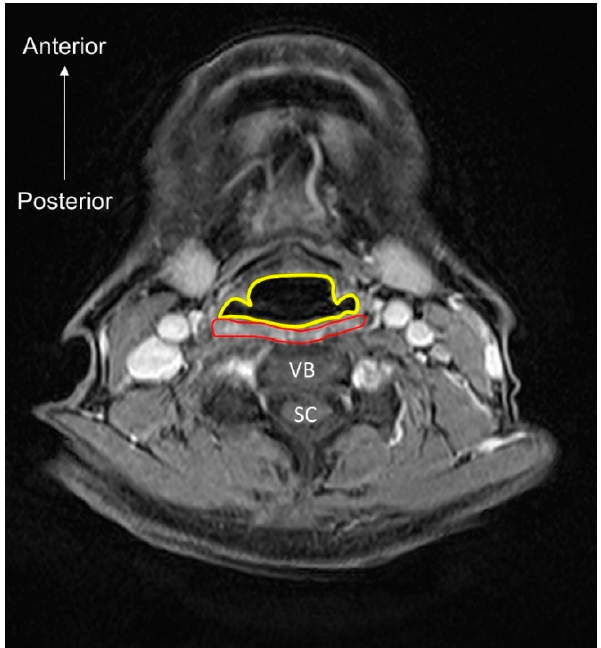
Figure 9. MRI (axial view) of the pharyngeal lumen (encircled by the yellow line) and muscle (encircled by the red line). VB, vertebral body; SC, spinal cord.